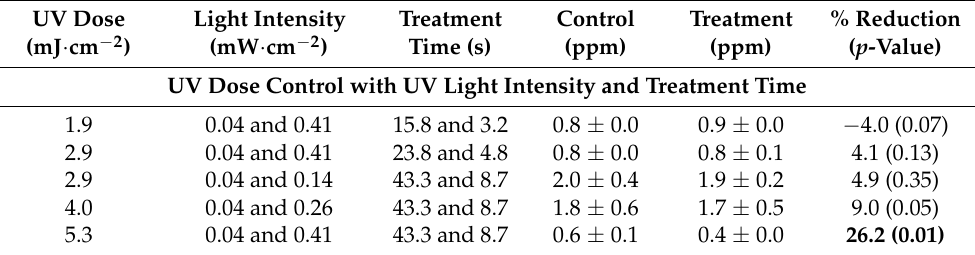
Table 5. Mitigation of H 2 S with UV-A photocatalysis treatment. Control temperature = 28.5 ± 2.3 ◦ C, in the table are mean ± S.D. Bold signifies statistical